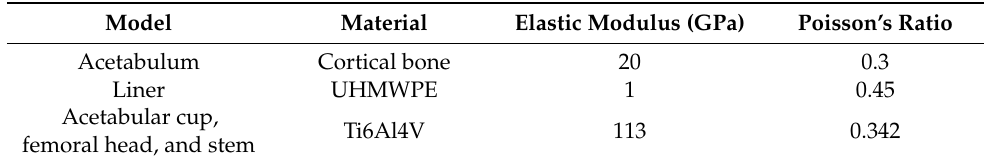
Figure 4. Finite element model of the total hip joint.